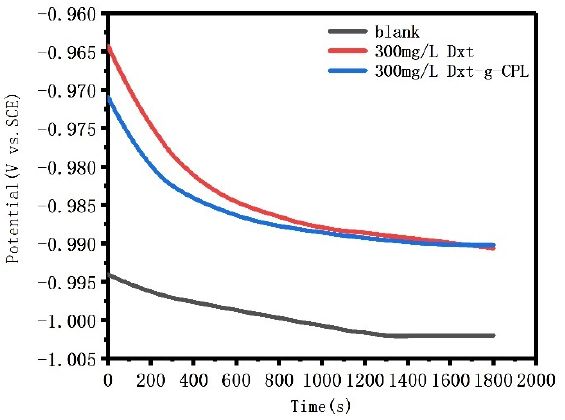
Figure 6. The open circuit potential of J55 steel with Dex and Dex-g-CPL added to 1 M HCl solution.